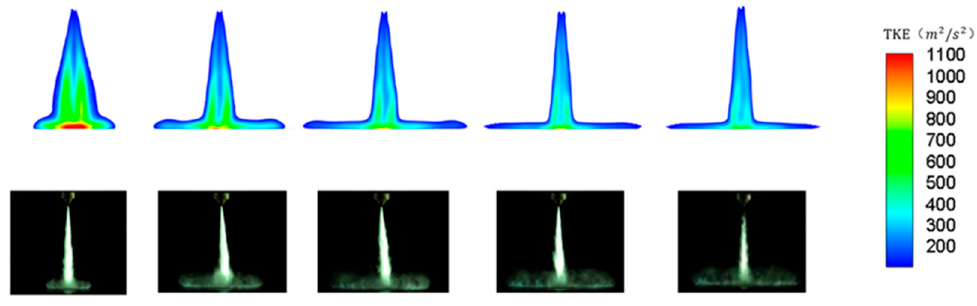
Figure 9. Experimental photos and TKE distribution.